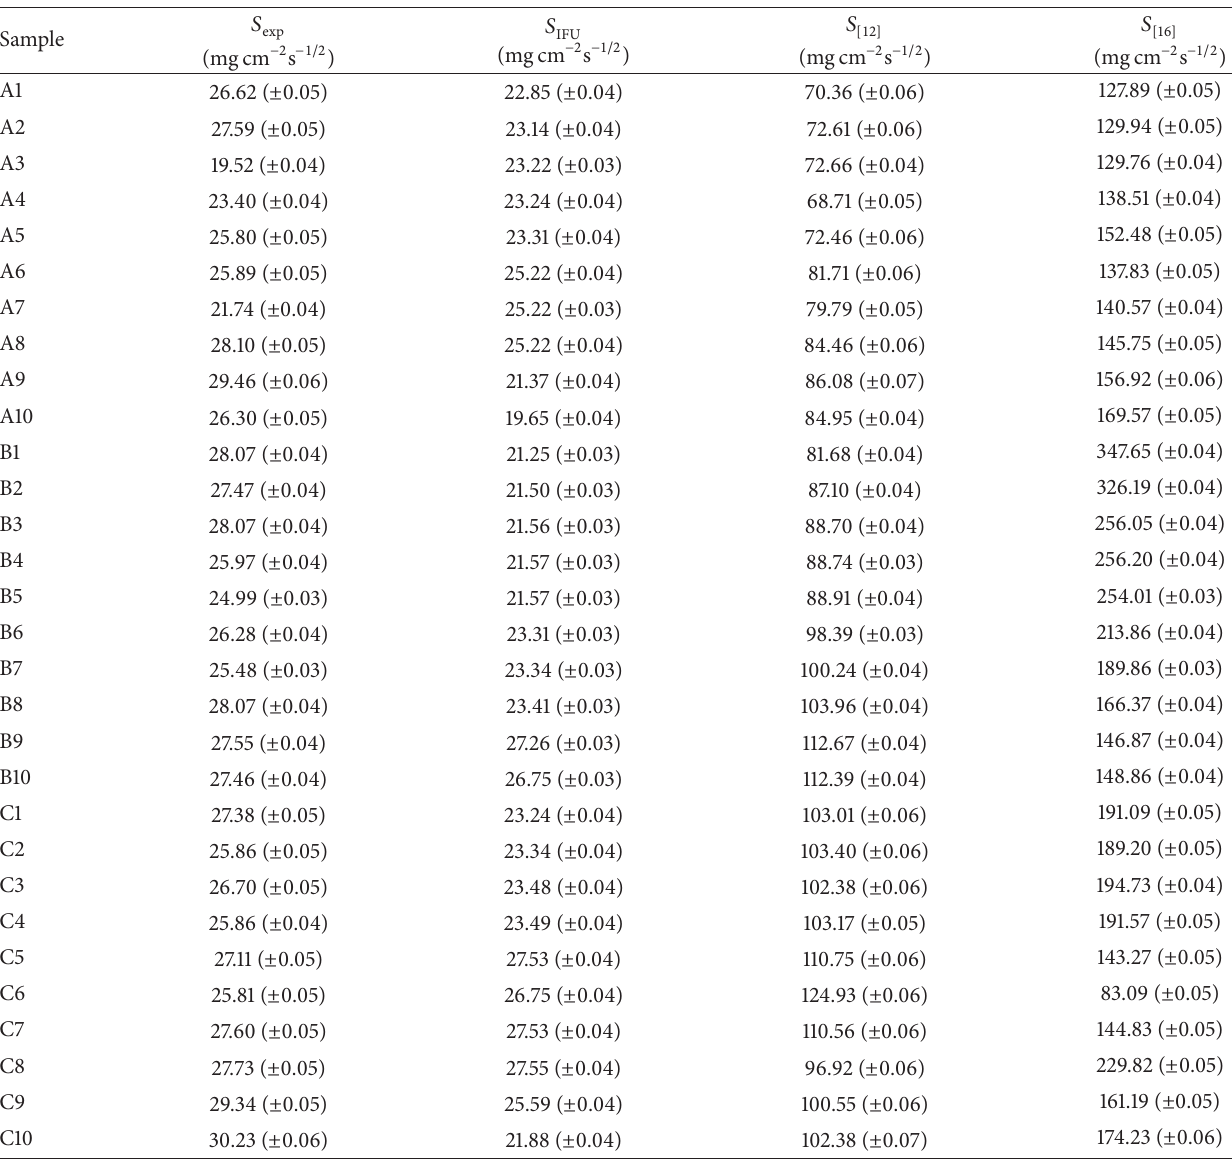
Table 3: Sorptivity coefficient of calcareous stone. 𝑆 exp , experimental sorptivity; 𝑆 IFU , IFU sorptivity; 𝑆 [12] , sorptivity calculated according to the formula reported in Scherer and Wheeler [12]; 𝑆 [16] , value calculated according to the formula reported in Raimondo et al. [16] (values are accompanied by the relative error in the